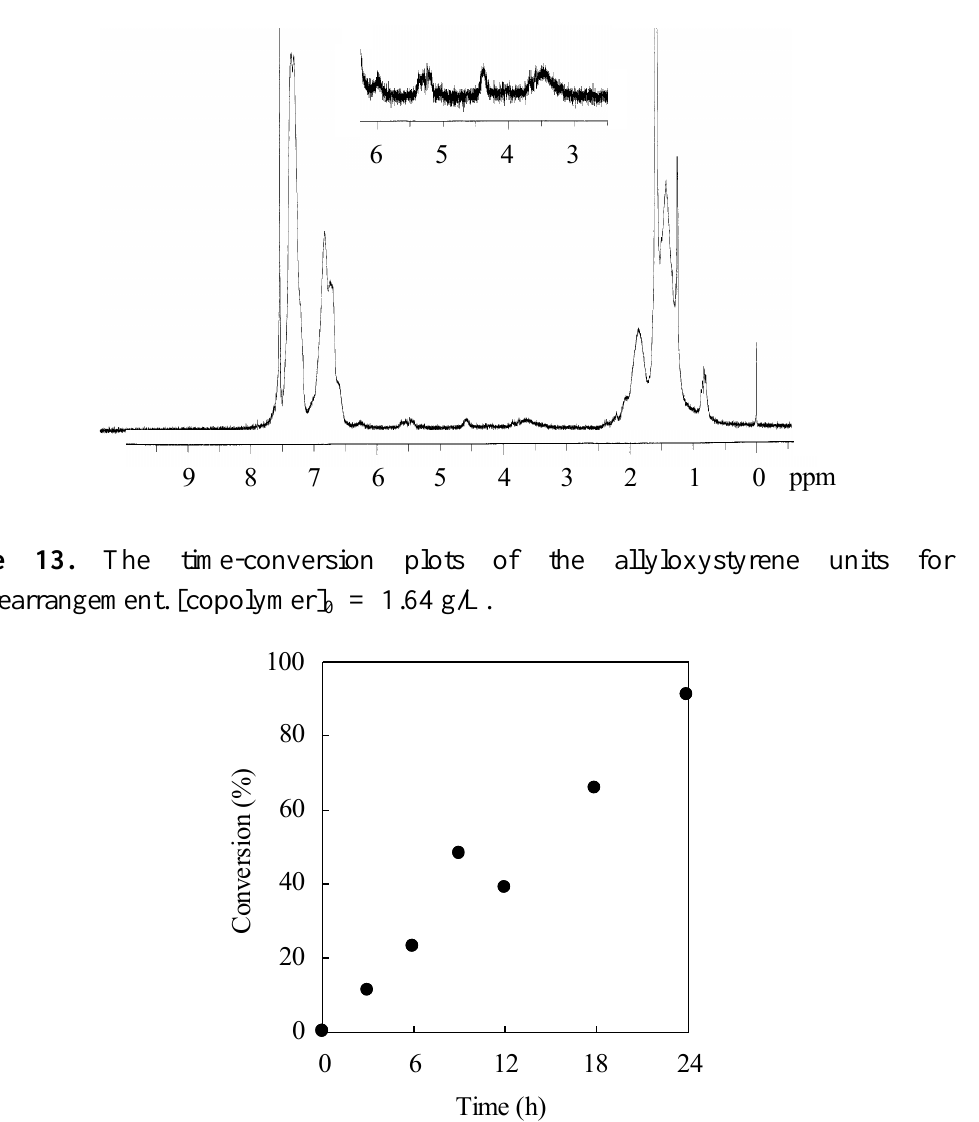
Figure 12. 1 H NMR spectrum of the copolymer obtained by irradiation of PASt- b -PSt. Solvent: CDCl . 3